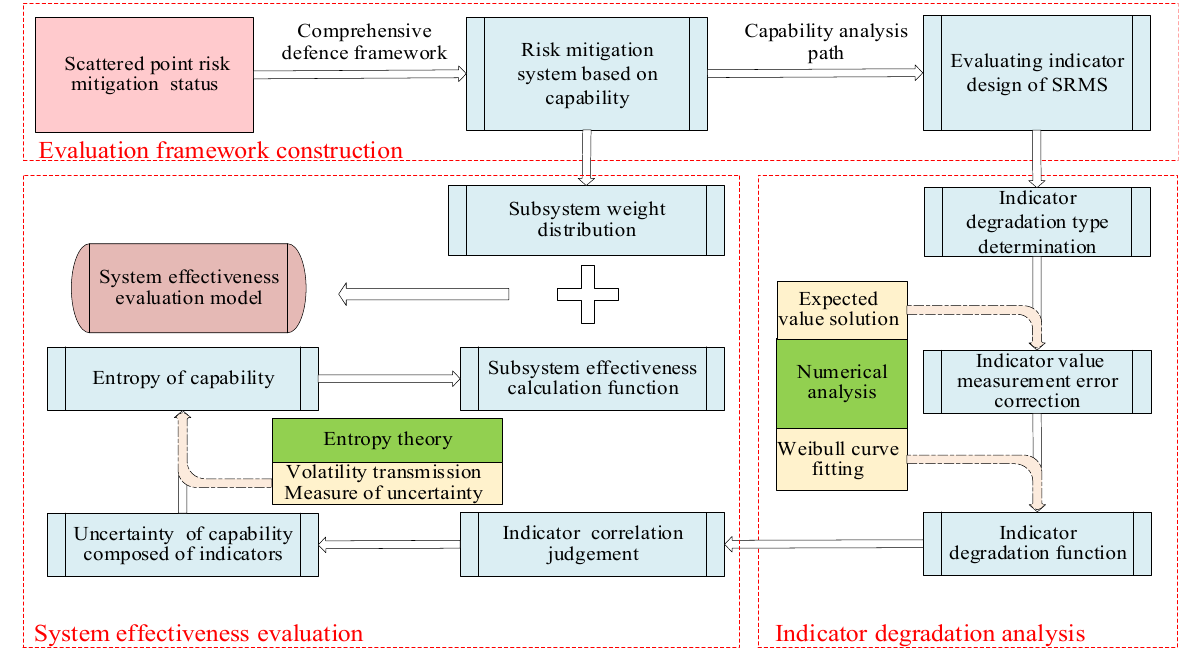
Figure 1. Schematic diagram of the effectiveness evaluation model based on entropy theory.